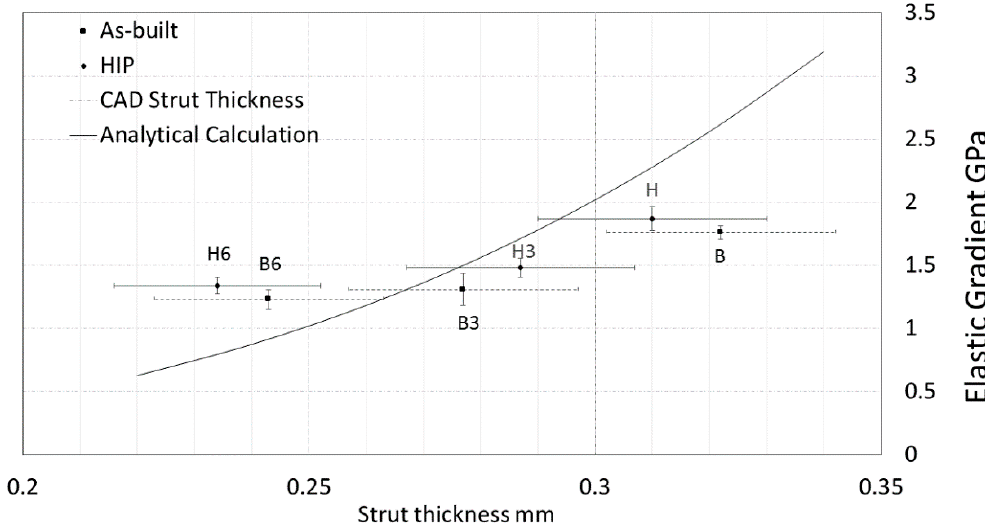
Figure 6. The e ff ect of posttreatment on strut thickness and elastic gradient of the porous structure.